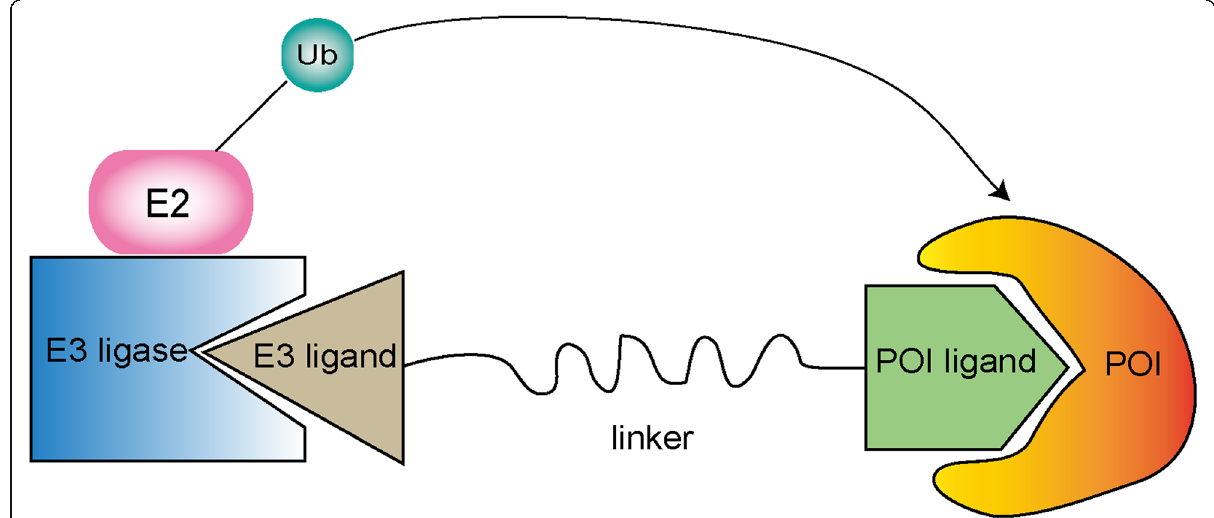
Fig. 5 Schematic diagram of PROTACs. A Graphical representation of the components and process of PROTACs. The PROTACs consist of three important parts, including a ligand binding to the POI, a covalently linked ligand of an E3 ubiquitin ligase and a linker to link these two